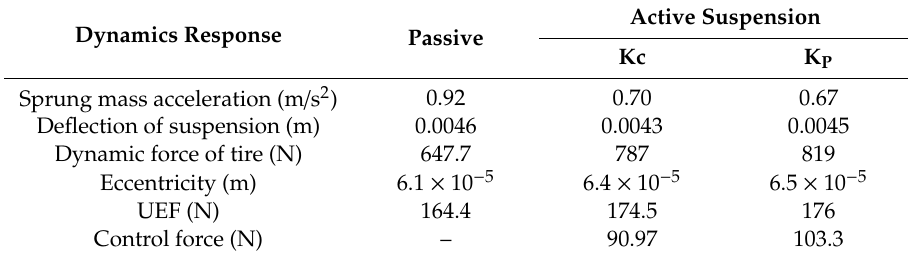
Table 1. The root mean square (RMS) of electric vehicle (EV) responses.